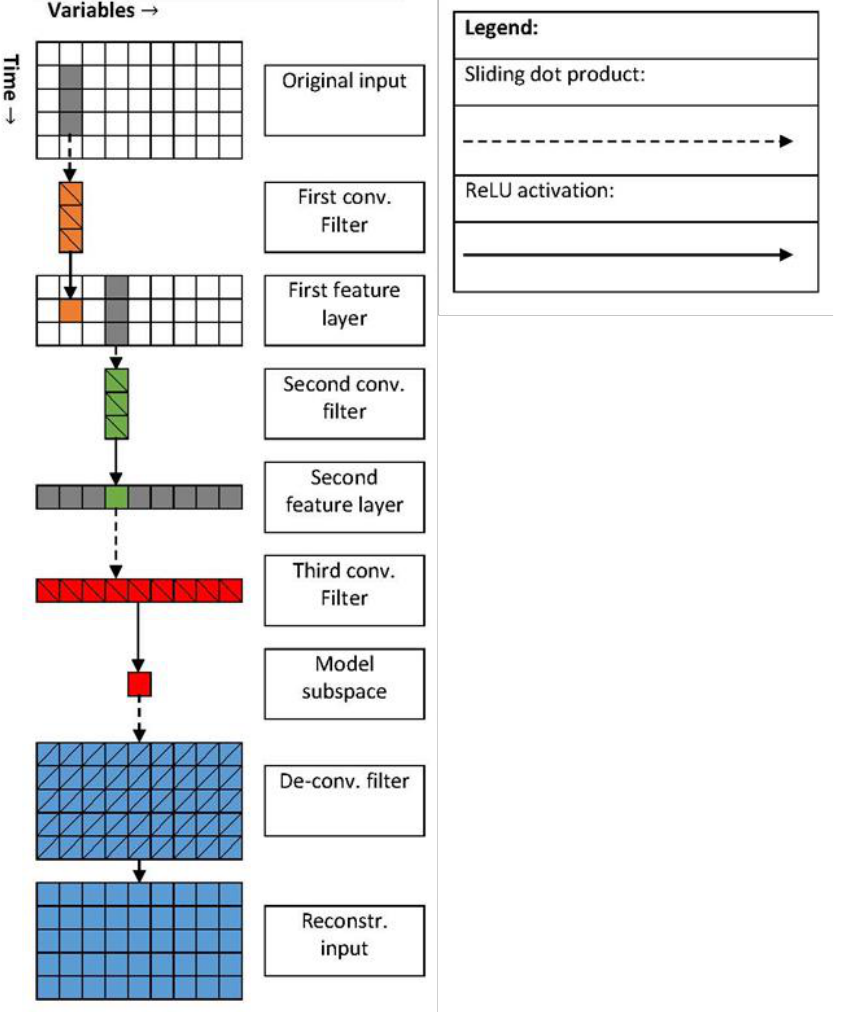
Figure 11. Illustration of the CAE architecture evaluated in this project [20]. Convolutions that are applied vertically convolve a feature in the time dimension. Horizontal convolutions convolve across the variables in a feature. In the example, the first convolutional filter maps three input features to a single feature in the first feature layer (orange blocks), the second convolutional filter maps three features to a single feature in the second feature layer (green blocks), the third convolutional filter maps nine features into a single feature (red blocks), and the final deconvolutional filter maps single features into a reconstructed output with 45 features (blue blocks). See Table 7 for further details.